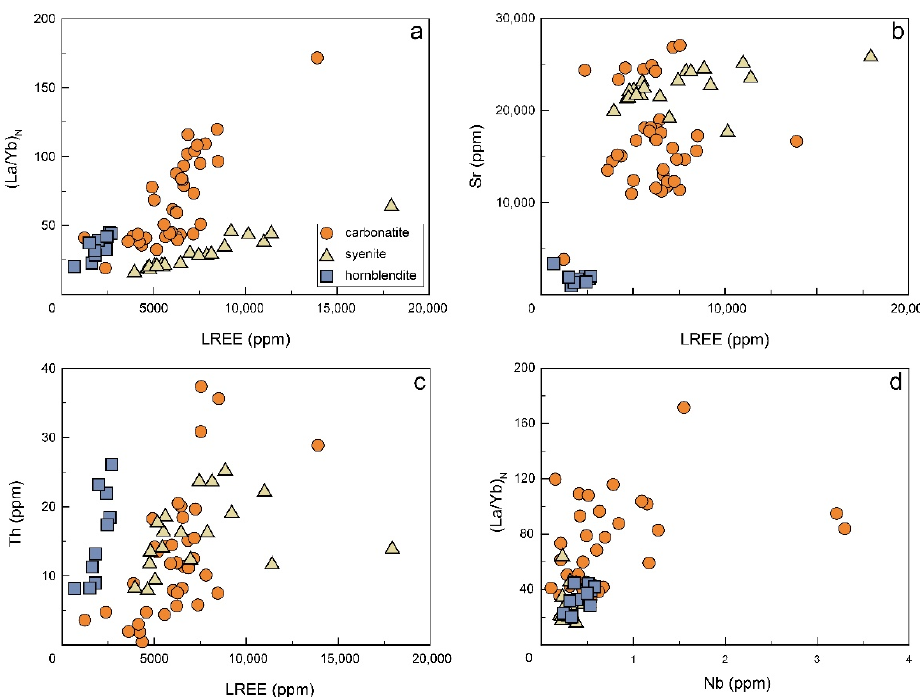
Figure 7. Variation diagrams of LREEs with ( a ) (La/Yb) N , ( b ) Sr, ( c ) Th, and ( d ) Nb vs. (La/Yb) N for the apatites in SXD complex.